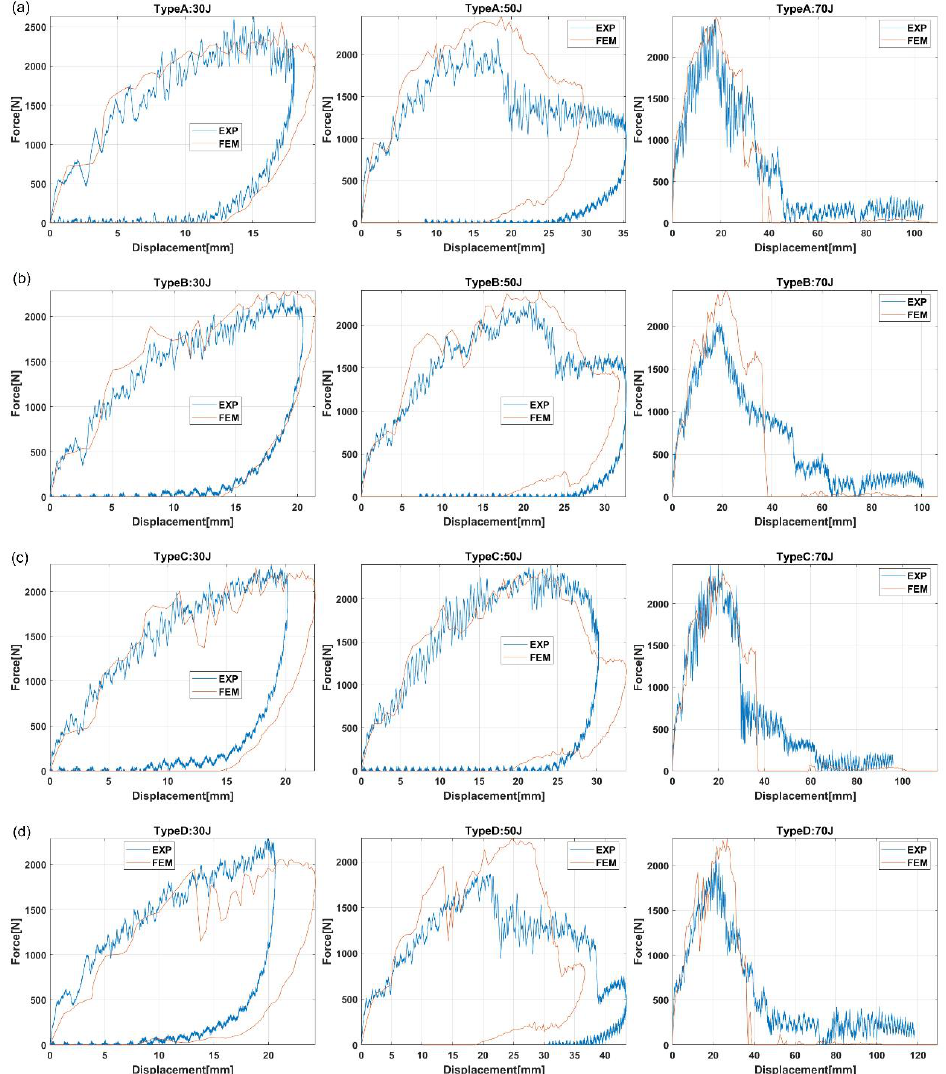
Figure 12. Force versus displacement curves of all the bumper beam types. Comparison between the experimental and the numerical results. ( a ) Curves for Type A; ( b ) Curves for Type B; ( c ) Curves for Type C; and ( d ) Curves for Type D.